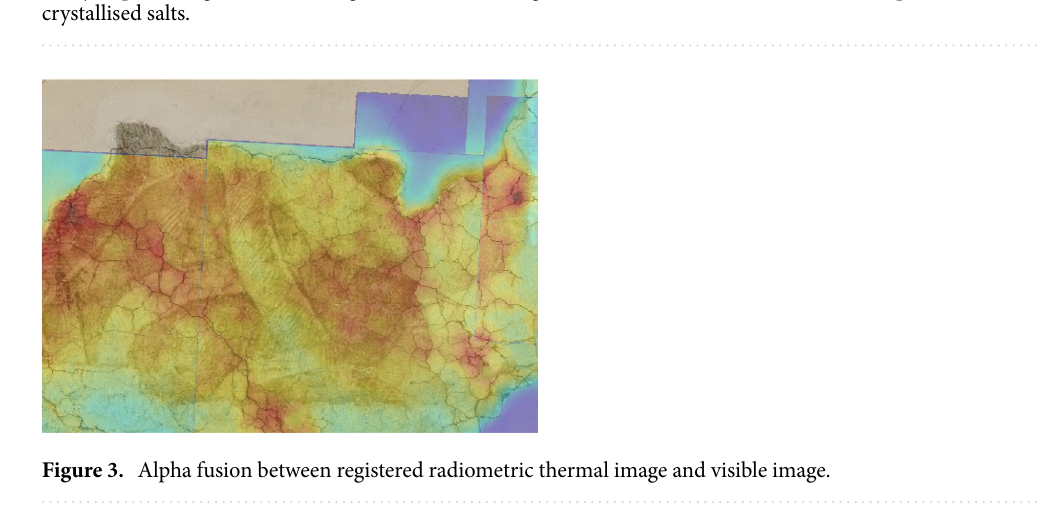
2.5 m, 500 µ m pixel size ×